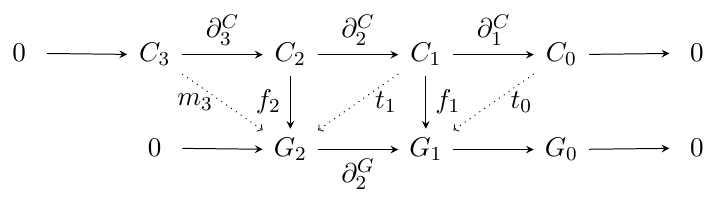
Figure 4 . Chain complexes for the 0 ; 1 ; 2-gauge model